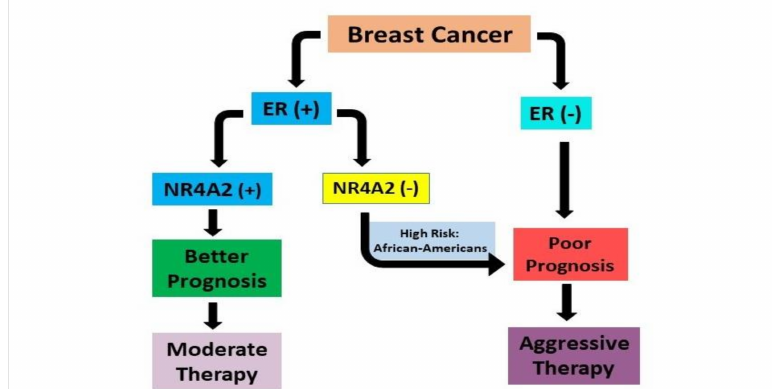
Figure 7. ER(+) breast cancer with low expression of NURR1(NR4A2) could result in poor prognosis leading to aggressive chemotherapy. Patients with positive expression of NURR1 in ER (+) BCa respond favorably to moderate therapy. African-American women with ER(+) BCa showed low levels of NURR1 and thus at high risk of poor